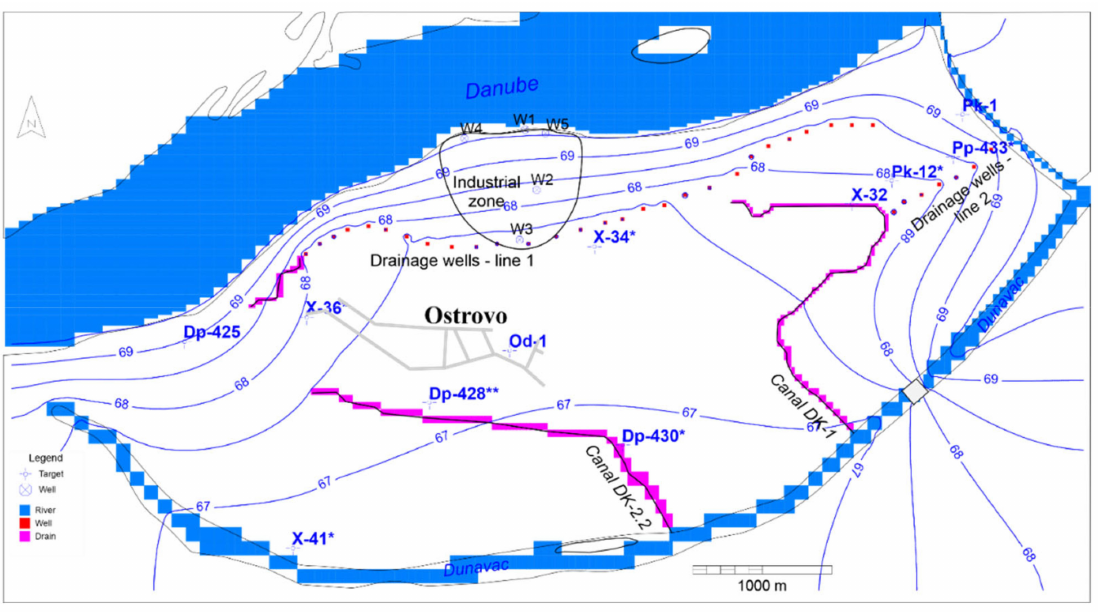
Figure 7. Water level distribution of the second model layer (sandy sediments) at low stages of the Danube.